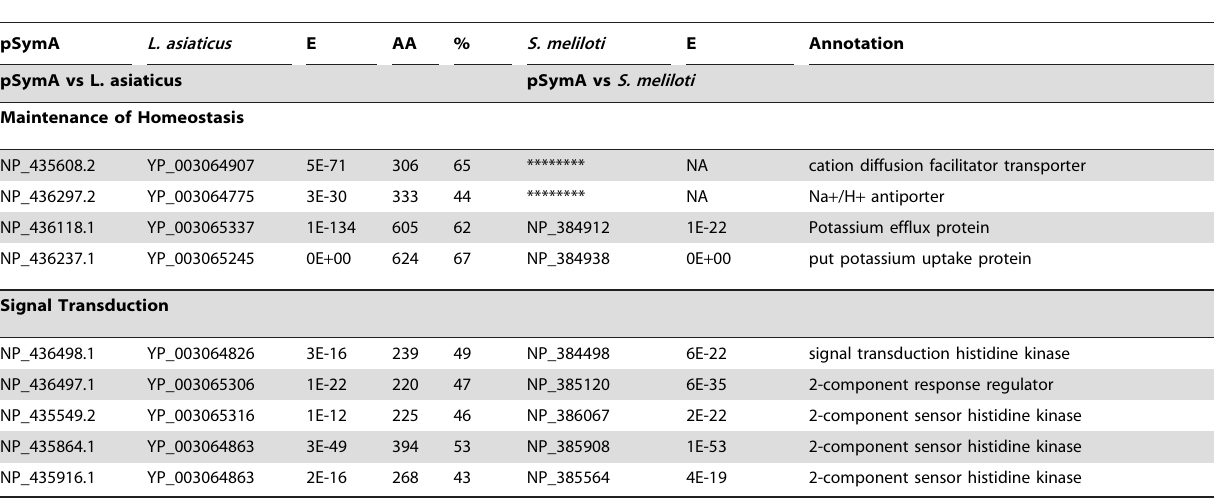
Table 1. Proteins shared between the Sinorhizobium meliloti plasmid pSymA, and the ‘ Ca . Liberibacter asiaticus’ and Sinorhizobium meliloti chromosomes and with roles in the maintenance of homeostasis or signal transduction.